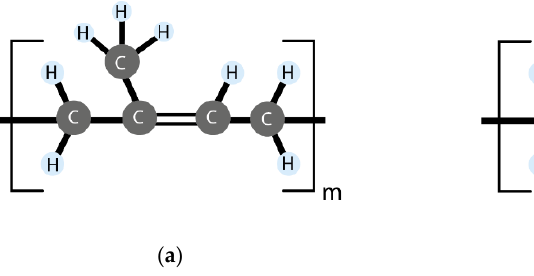
Figure 5. ( a ) NR chemical structure, ( b ) ENR chemical structure.